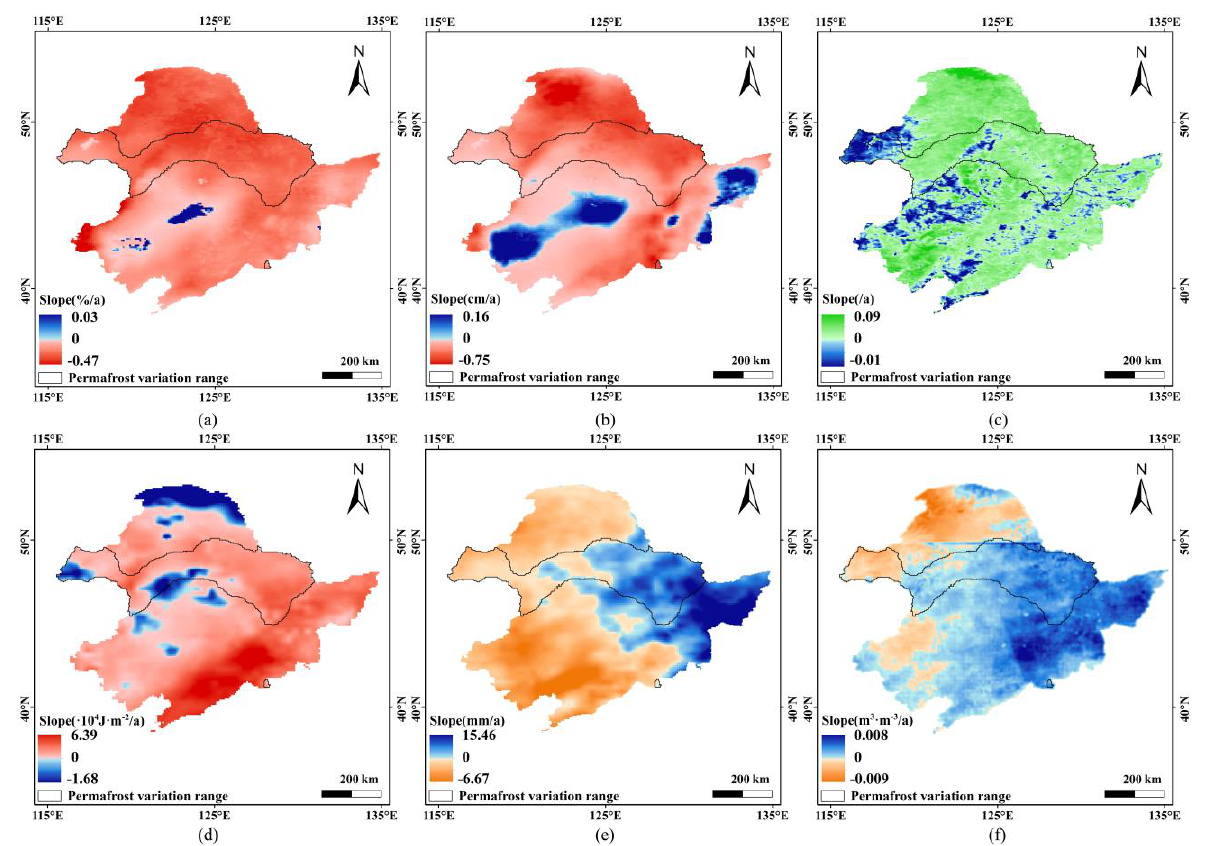
Figure 7. The spatial distributions of trends in the permafrost influencing factors: ( a ) annual average snow cover; ( b ) annual average snow depth; ( c ) annual average NDVI; ( d ) annual average solar radiation; ( e ) annual average precipitation; ( f ) annual average 0 – 7 cm soil water content.